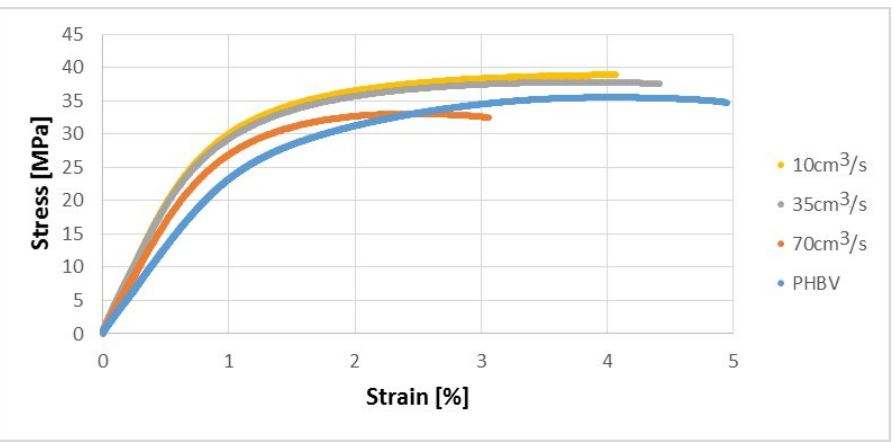
Figure 6. Stress–strain characteristics for tested samples produced at a variable injection rate com- pared to a pure PHBV sample produced at 35 cm 3 /s.